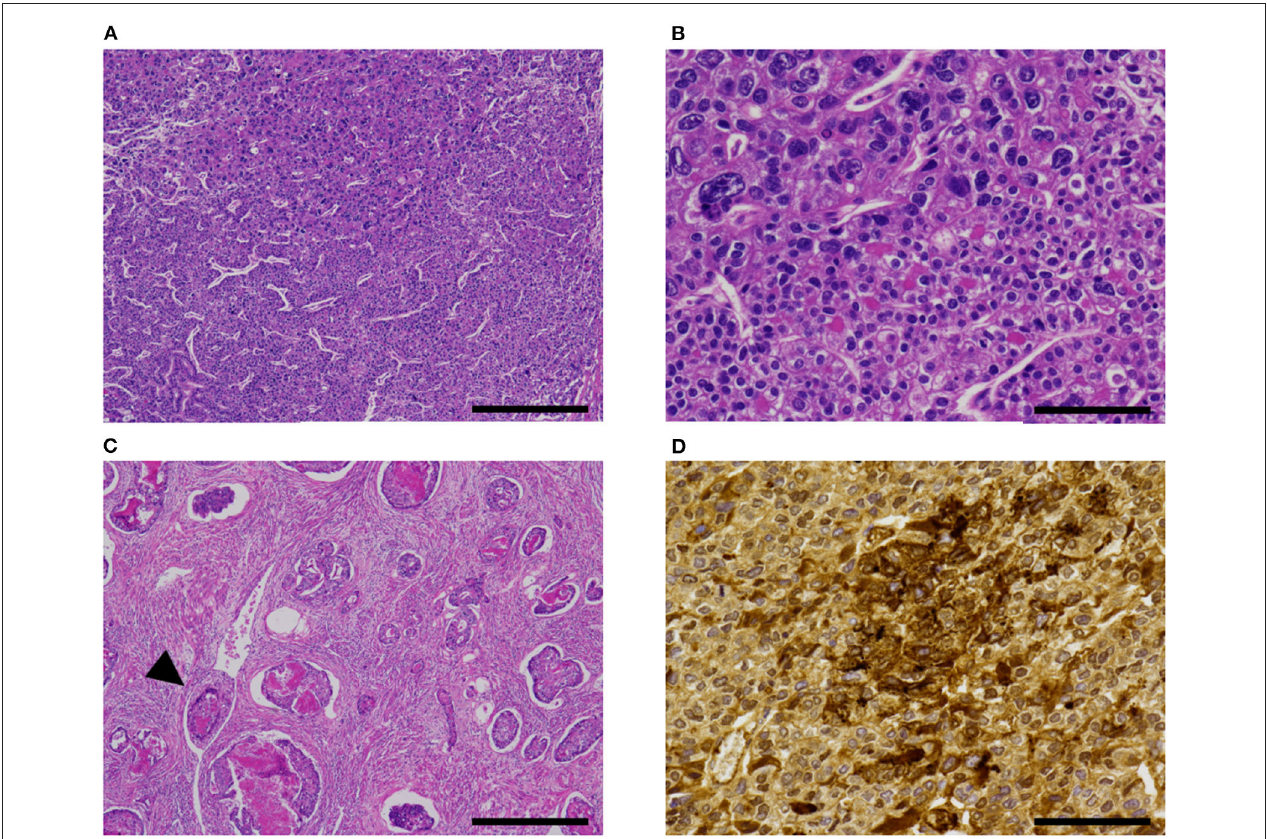
FIGURE 3 | Hepatoid carcinoma (case 3). (A) This pattern was composed of tightly arranged trabecular neoplastic epithelium with intervening sinusoid-like capillaries. (B) Canaliculi-like small lumina were also observed. Tumor cell nuclei had coarse chromatin and showed moderate to severe nuclear atypia. (C) In case 3, this carcinoma exhibited extensive myoinvasion and vascular invasion (arrowhead; retraction clefts are also pictured). (D) Neoplastic cells were positive for AFP (D) . Hematoxylin-eosin (A–C) ; original magnification × 40 (A,C) and × 200 (B,D) ; scale bars = 500 µ m (A,C) and 200 µ m (B,D) . AFP, α -fetoprotein.